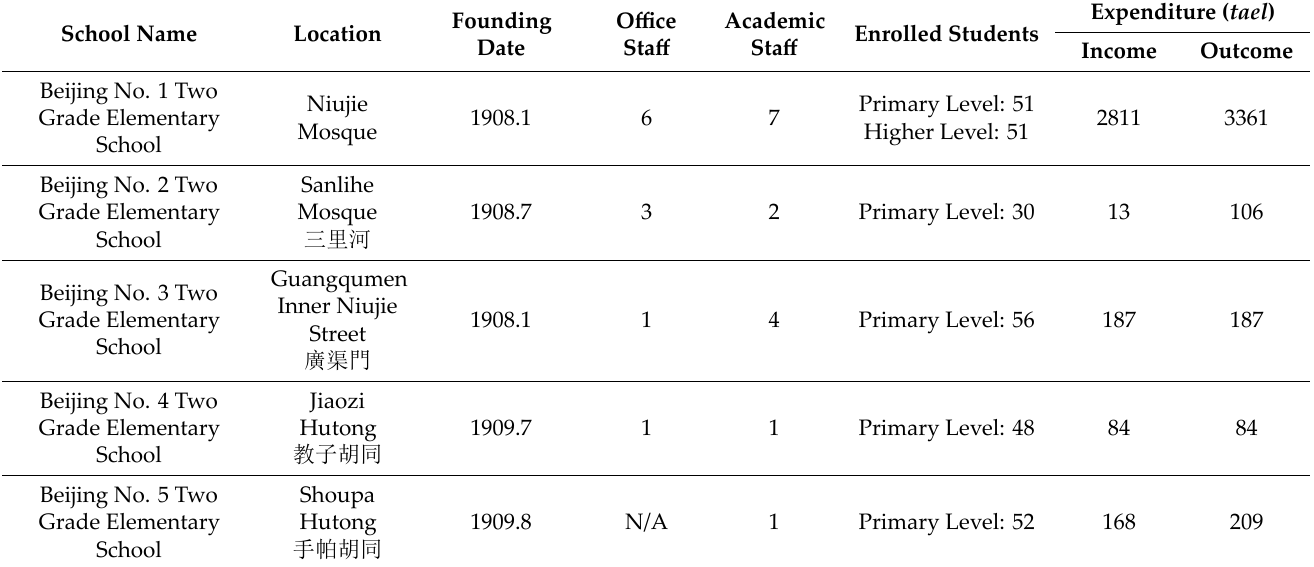
Table 2. Beijing No.1 Two Grade Elementary School and its branch